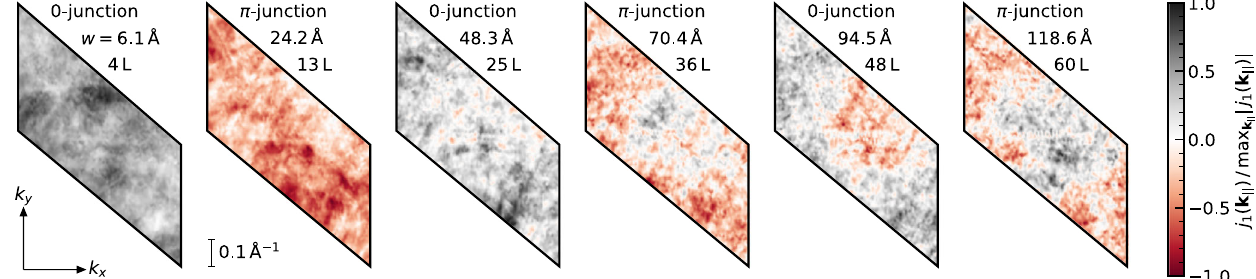
ð w Þ shown in Fig. 7. For 4 and 13 layers, all the k ∥ 1